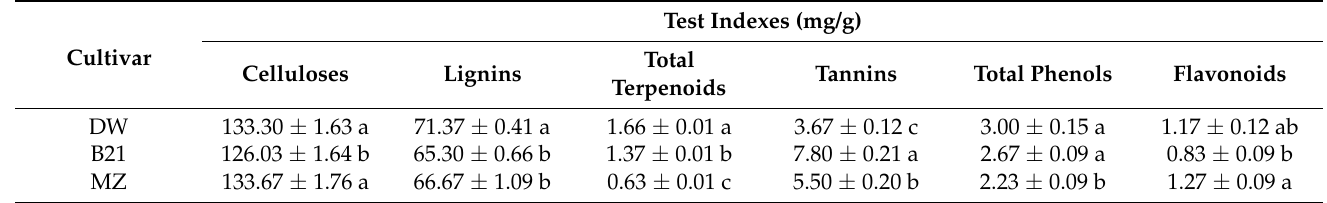
Table 4. The content of insect-resistant compounds in hazelnut shells of different hazel cultivars after chewing by C. nucum.